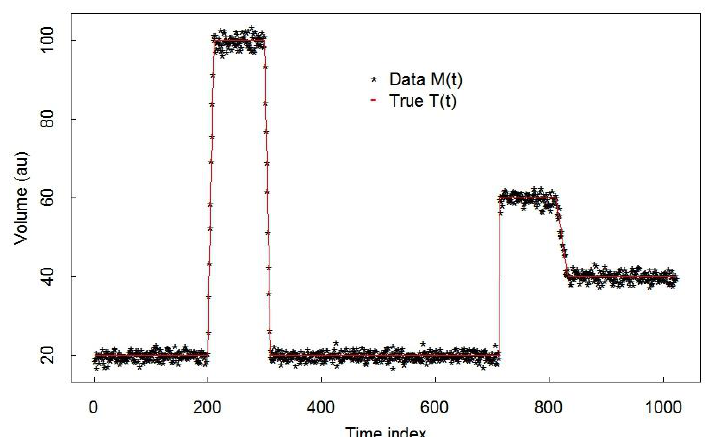
Figure 1. Simulated data M ( t ) from Equation (1).